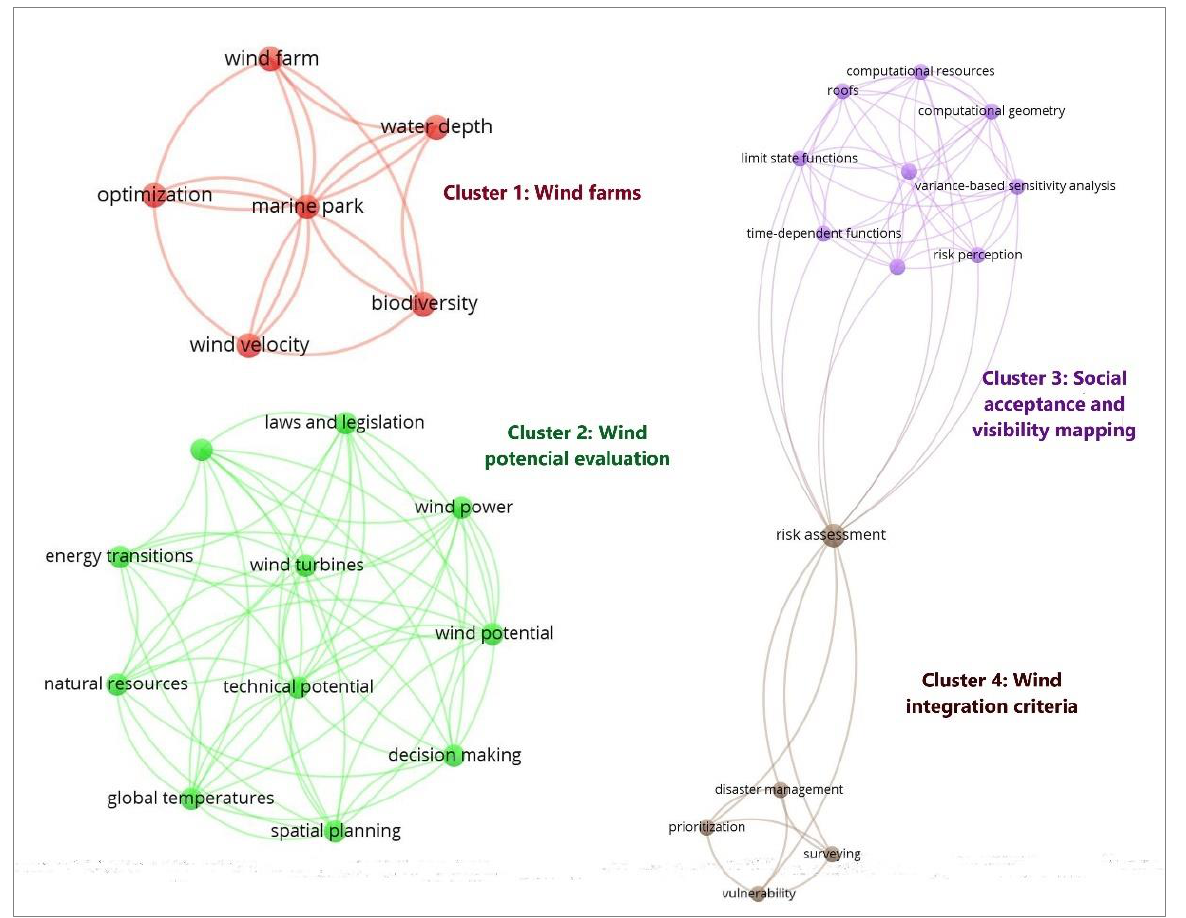
Figure 14. Main clusters of the studies on wind energy and architectural heritage based on co-occurrence network of the selected indexed keywords (source: Author ’ s elaboration using VOSviewer, based on Scopus data).